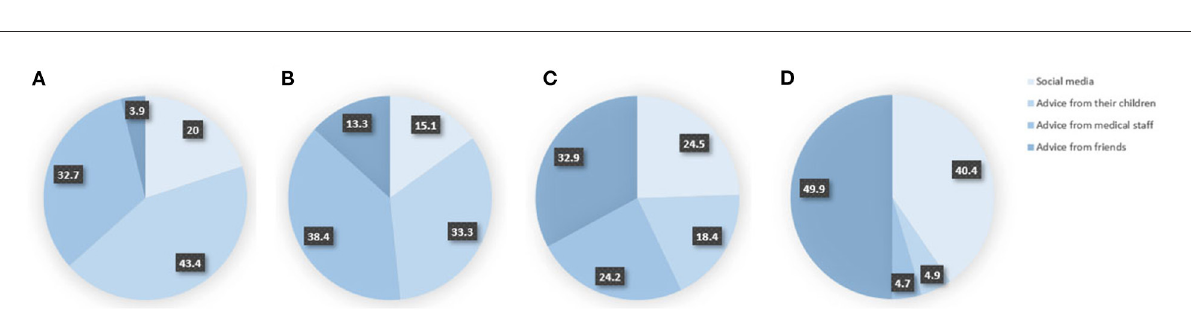
FIGURE3 Ranking of the influence degree of four factors on the willingness of the elderly to receive the booster vaccination. (A) The most important, (B) the second most important, (C) the third most important, and (D) the least important.